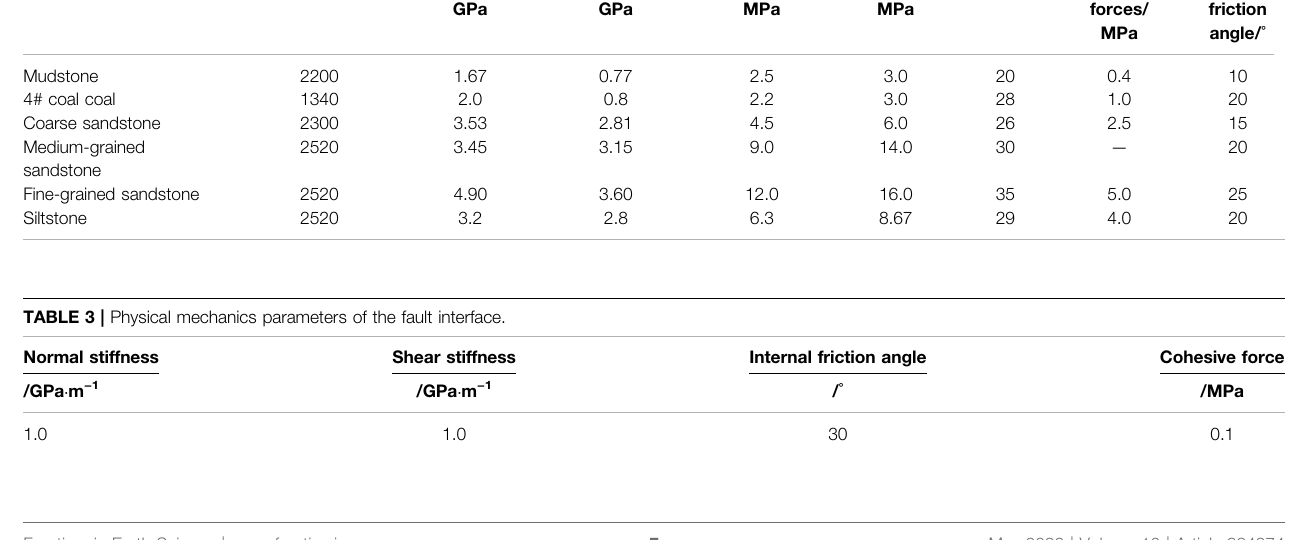
TABLE 2 | Physical mechanics parameters of coal rock seam.